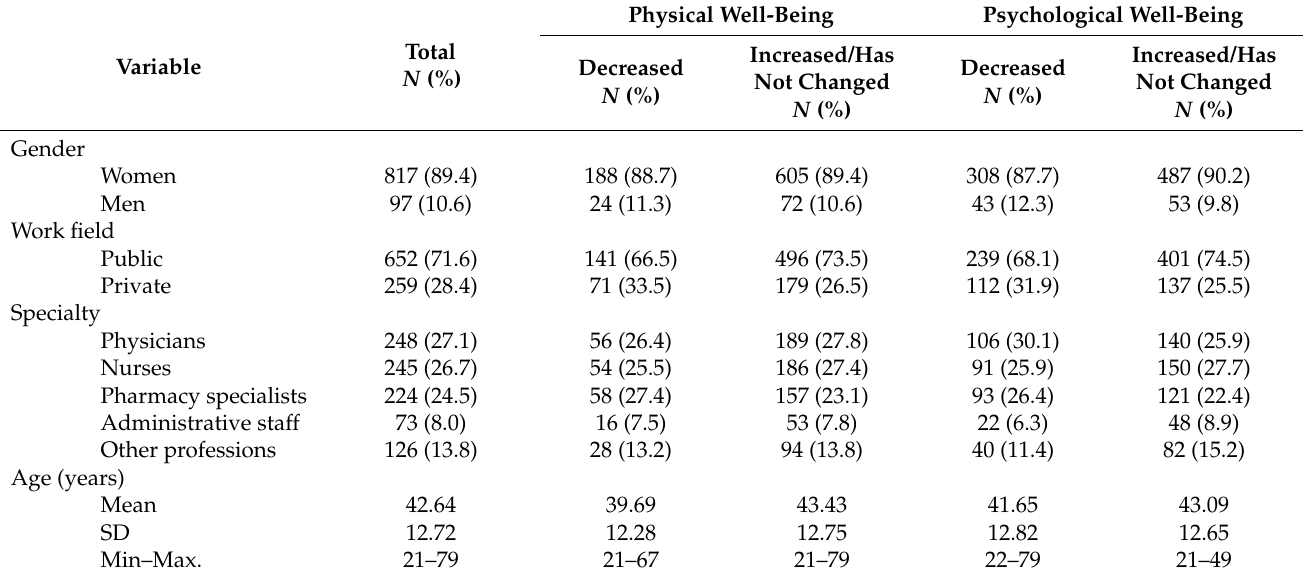
Table 2. Socio-demographic characteristics of the sample ( N = 921).